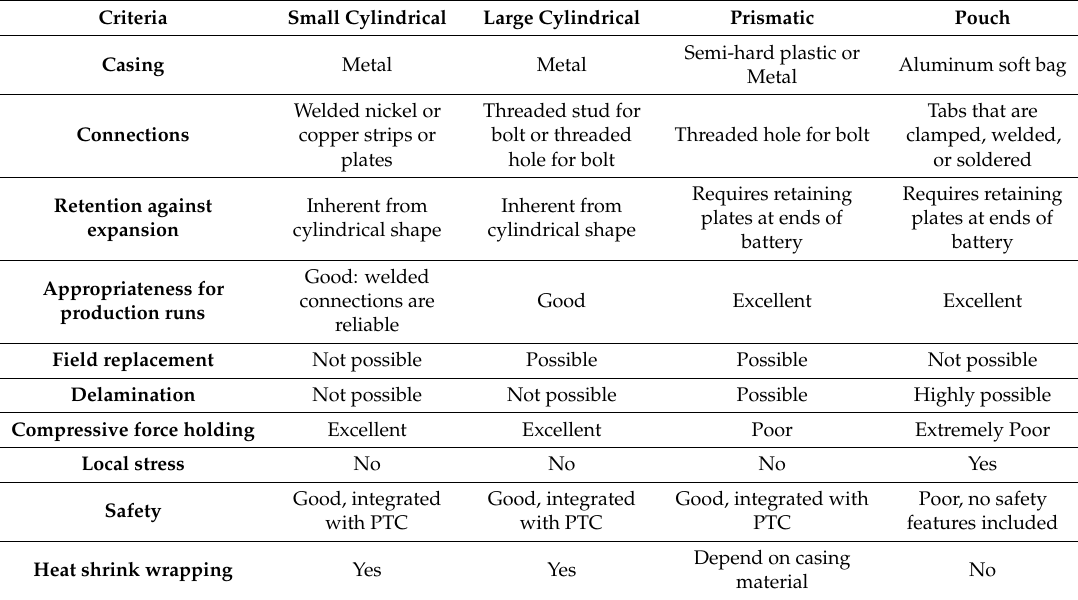
Table 4. Comparison of structural characteristics of different types of battery cells